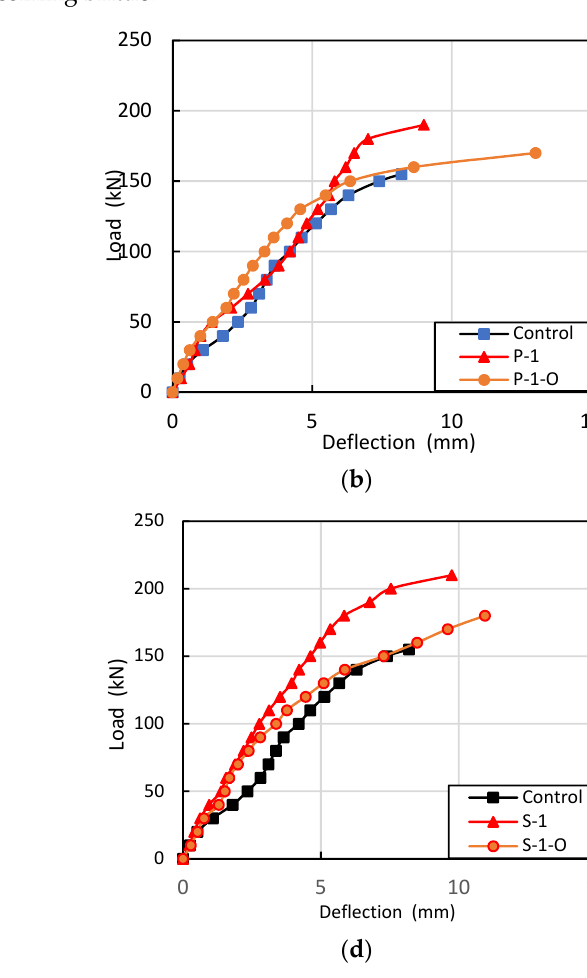
Figure 9. Load–deflection with different types of fiber. ( a ) Control slab with and without opening; ( b ) Slab with polyolefin fiber; ( c ) Slab with corrugated steel fiber; ( d ) Slab with straight steel fiber.